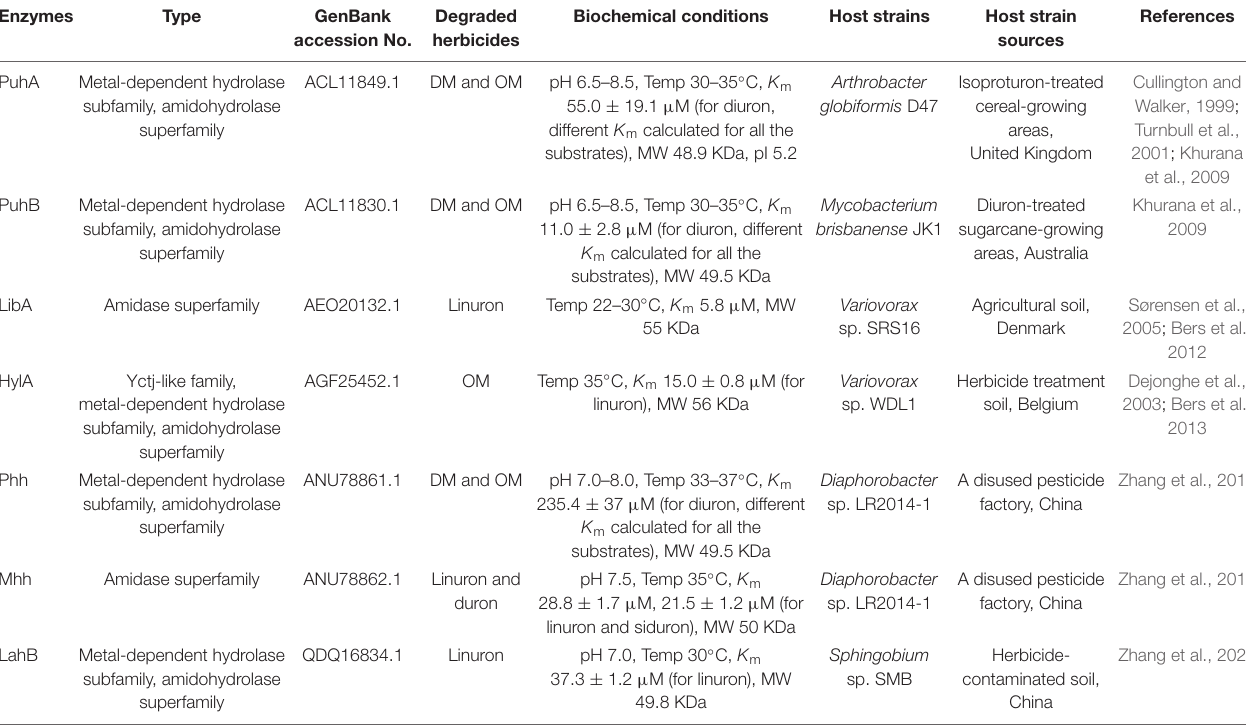
TABLE 3 | Phenylurea herbicide initial hydrolysis enzymes.